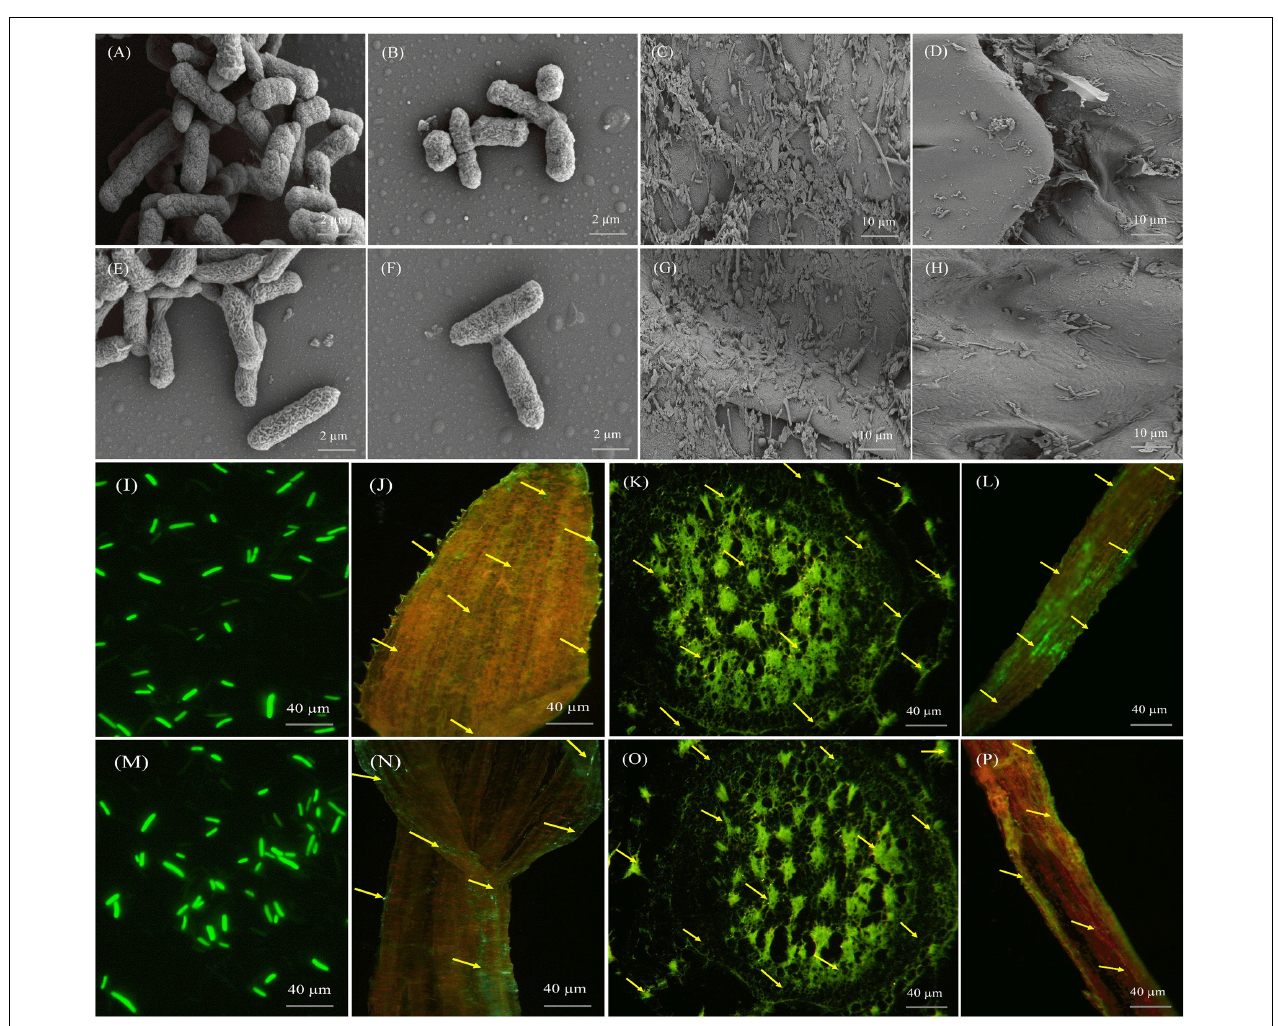
FIGURE 7 | Microscopic pictures presenting the morphology and colonization of Pantoea cypripedii AF1 and Kosakonia arachidis EF1 in sugarcane (GT42). (A,B,E,F) Scanning electron micrographs (SEM) displaying morphology (rod-shaped) of AF1 and EF1 bacteria. (C,D,G,H) Colonization of AF1 and EF1 in root and stem tissues of sugarcane plant. (I,M) Confocal laser scanning micrographs (CLSM) displaying morphology of GFP tagged AF1 and EF1 strains. (J–L,N–P) Colonization of AF1 and EF1 strains as green dots in leaf, stem, and root tissues of sugarcane.